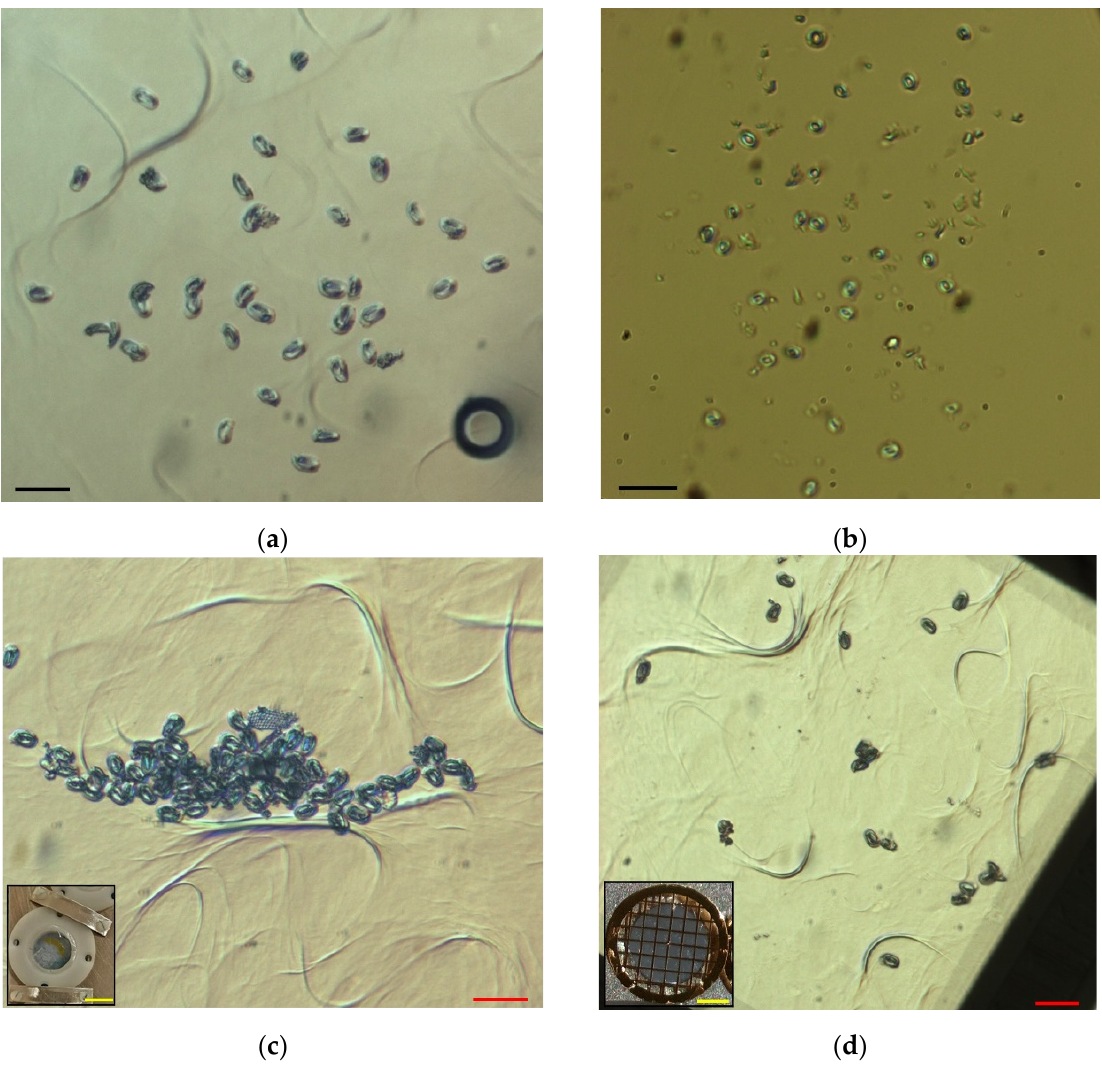
Figure 4. Nannofossils isolated in a single capture–release procedure and deposited on a Petri dish for the species H. carteri ( a ) and G. oceanica ( b ), scale bars 10 μ m; H. carteri coccoliths isolated for synchrotron-based analyses and deposited on ( c ) Mylar film sealed with a Delrin interlocking ring, scale bars are 1 cm (yellow) and 20 μ m (red), and on ( d ) an Au TEM grid with a Formvar layer scale bars are 1 mm (yellow) and 20 μ m (red).